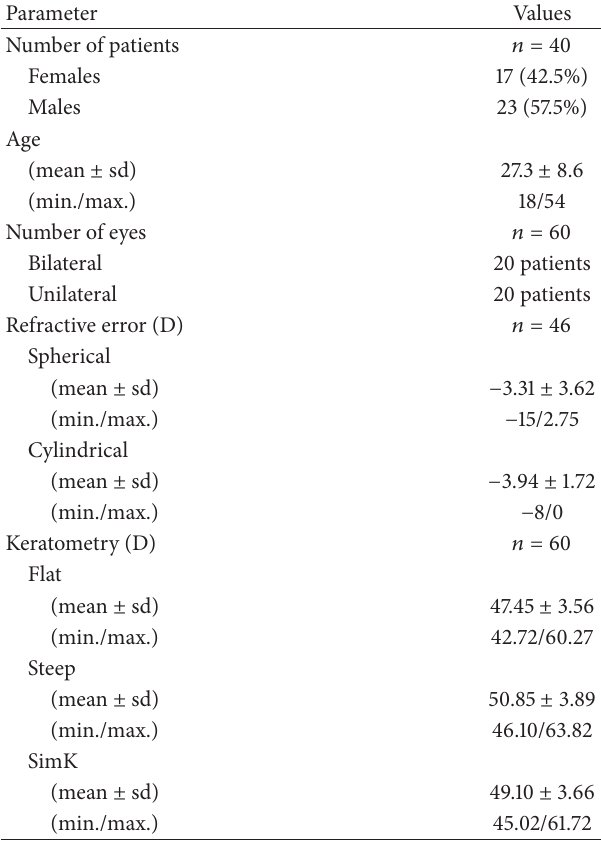
Table 2: Demographic information of the population enrolled in the